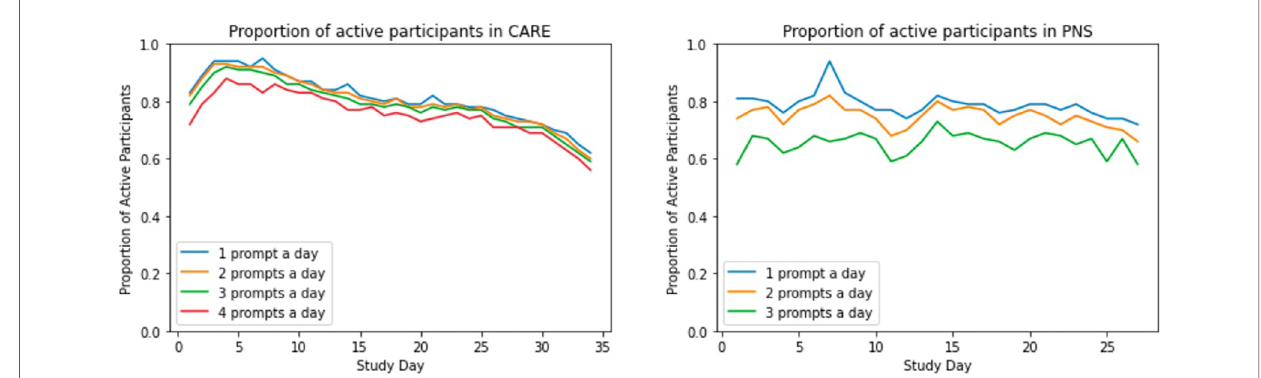
FIGURE 1 Trends in the proportion of participants with prompts delivered: proportion of participants who received at least 1, 2, 3, or 4 prompts per day in the course of the CARE and PNS studies. Note that in the PNS study the maximum number of prompts per day was